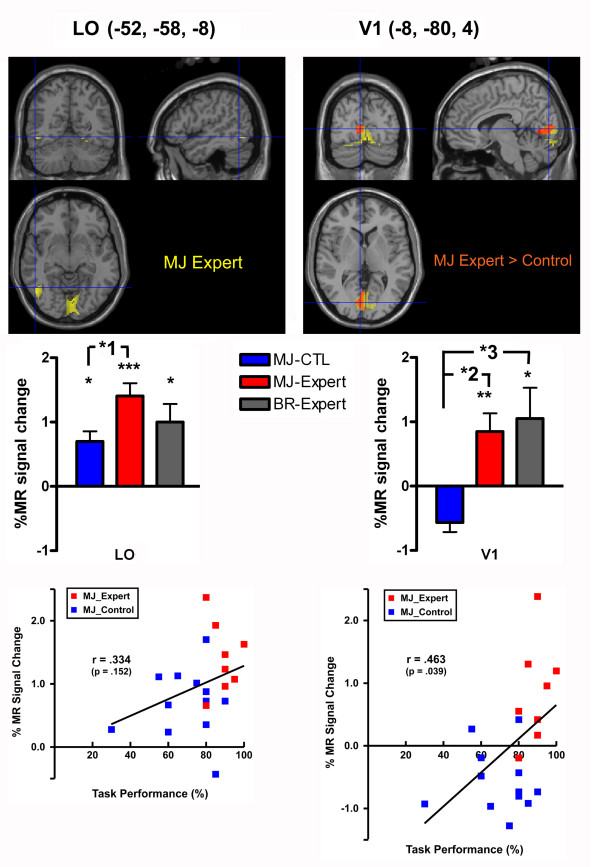
(Top row) Statistical parametric maps of the group analysis of the neural activity of the expert subjects during tactile Mah-Jong discrimination. Task-related increases in the MR signal (yellow) were superimposed on three orthogonal sections of T1-weighted high-resolution MRIs unrelated to the subjects of the present study. The fMRI data were normalized to standard stereotaxic space. The blue lines indicate the projections of each section that cross at (x = -52 mm, y = -58 mm, z = -8 mm in MNI coordinates) where the activation was maximal in the LO when the experts were completing the task. (Top right) The group difference between the experts and the non-expert control group during Mah-Jong tactilediscrimination (orange) within the areas activated by expert group(yellow) are shown in the same format. The V1 of the expert groupshowed more prominent activation than that of the control group(orange). The blue lines indicate the projections of each section that cross at (-8, -80, 4) where the group difference was maximal. (Middle row) Task-related activation in the left LO (-52, -58, -8) (middle left), and V1 (-8, -80, 4) (middle right). The percent MR signal change during Mah-Jong discrimination by the non-expert control group (blue bar) and the experts (red bar) were plotted. The percent MR signal change during Braille discrimination by seven out of the eight experts (shaded bar) is also presented. * <0.05, ** <0.01, *** <0.001, one sample t-test. The group difference was also significant (*P = 0.02; ** P = 0.001; *** P = 0.003, Mann Whitney U-test). (Bottom row) The % MR signal change during Mah-Jong tactile discrimination by the expert (red square) and control groups (blue square) in the LO (left) and V1 (right). In V1 the task-related activity and task performance was positively correlated.